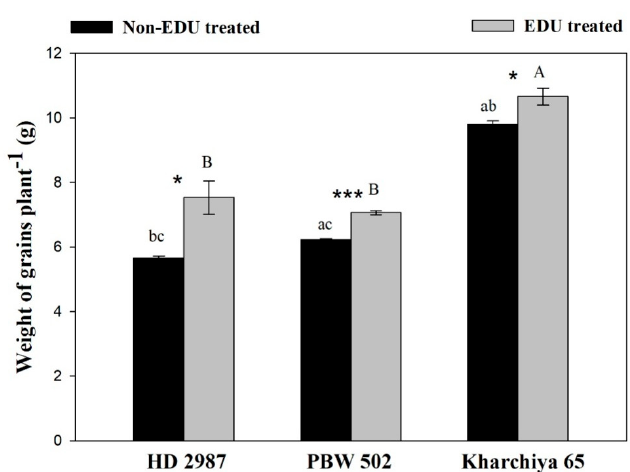
Figure 2. Effect of EDU on antioxidative enzymes such as superoxide dismutase (SOD), ascorbate peroxidase (APX), catalase (CAT), peroxidase (POX) and the superoxide radical production rate (SOR) in wheat cultivars. Values are mean ± SE; n = 9. Symbols above the bars represent significant variability between EDU- and non-EDU-treated plants. The one, two and three asterisks indicate the significance levels at *p ≤ 0.05, **p ≤ 0.01, and ***p ≤ 0.001, and ns is non-significant. Significant